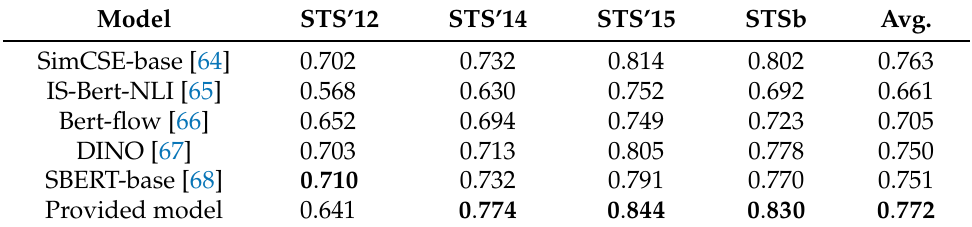
Table 3. Comparison of the Spearman’s rank correlation (Src) in each dataset.